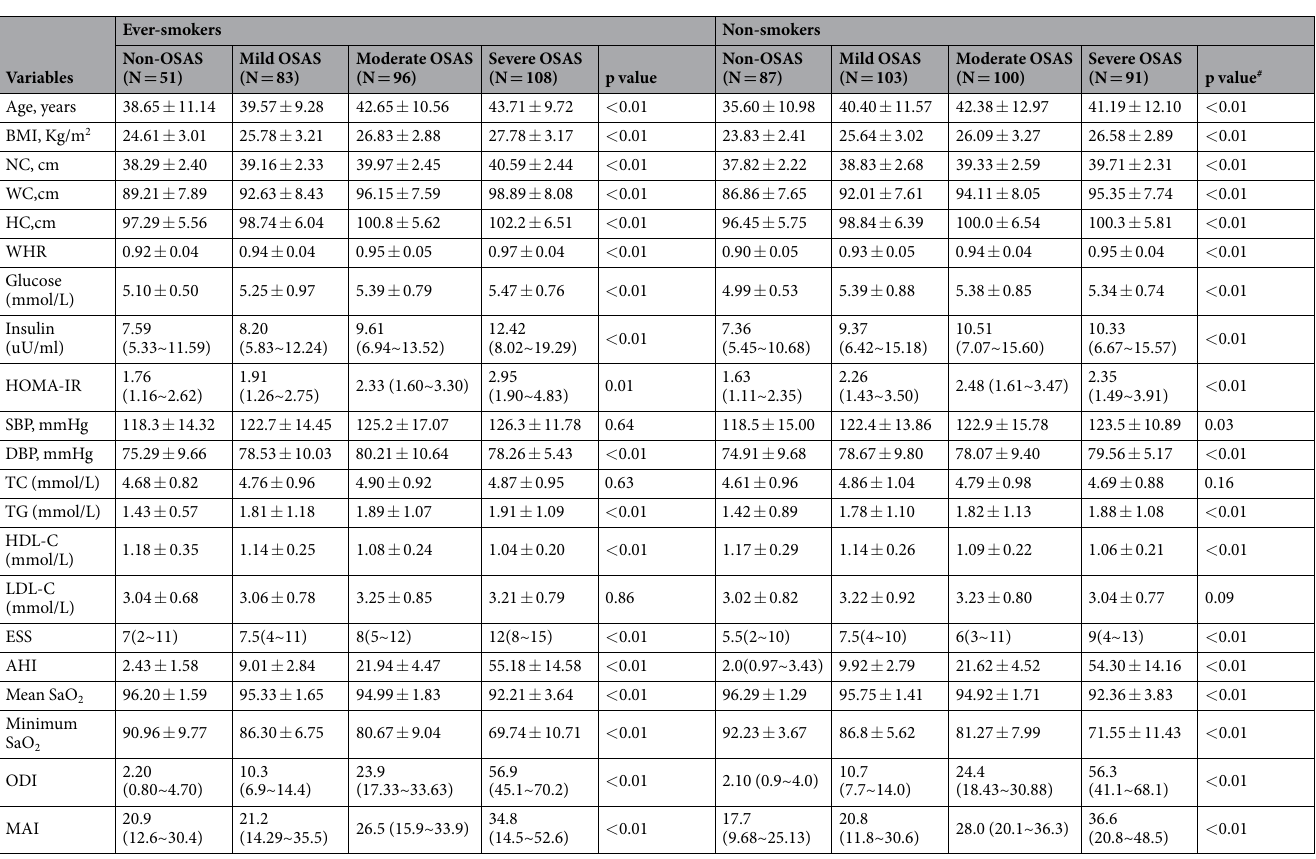
Table 2. Demographic and clinical characteristics of the enrolled subjects stratified by OSAS severity in both non- smokers and ever-smokers. Normally distributed data were presented as means ± standard deviation (SD), medians (interquartile range) and categorical data were presented as the number (percentage). # Tested using the polynomial linear trend test for continuous variables. Abbreviations: BMI, Body mass index; NC, neck circumference; WC, waist circumference, HC, hip circumference; HOMA-IR, homeostasis model of assessment for insulin resistence index; WHR, waist circumference/hip circumference ratio; SBP, systolic blood pressure; DBP, diastolic blood pressure; AHI, apnea- hypopnea index; SaO2, oxygen saturation; ODI, oxygen desaturation index; MAI, Micro-arousal index; ESS, Epworth sleepiness score; OSAS, obstructive sleep apnea syndrome; TC, total cholesterol; TG, triglyceride; HDL-C, high density lipoprotein cholesterol; LDL-C, low density lipoprotein